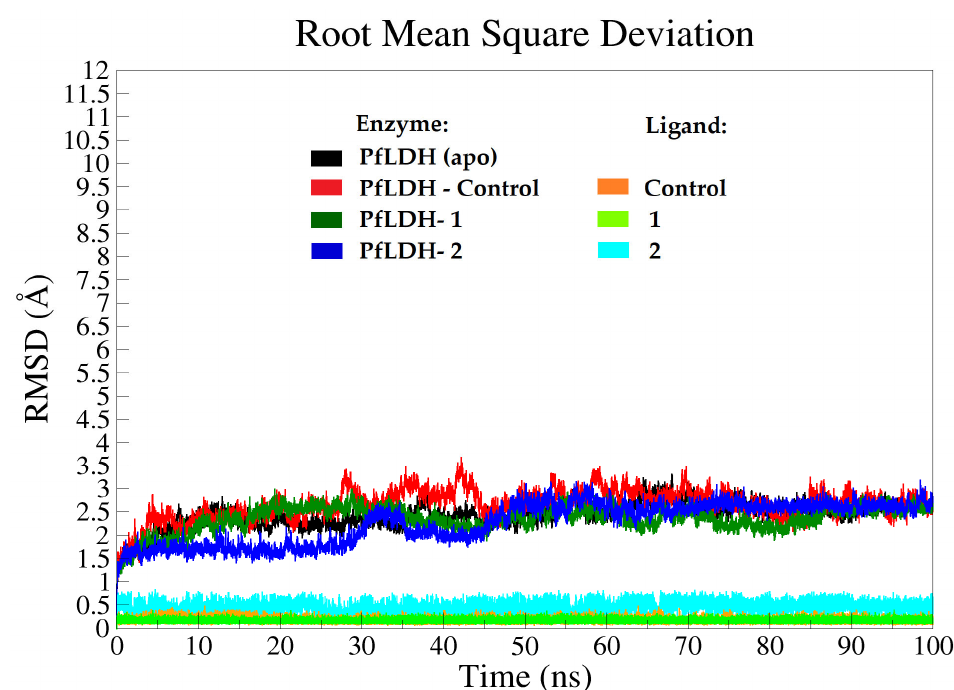
Figure 3. The root mean square deviation (RMSD) plots of the enzyme and ligand backbone atoms for the selected systems. Apo ‐ Pf LDH (black), Pf LDH ‐ control (red and orange), Pf LDH ‐ 1 (Dark green for the selected systems. Apo- Pf LDH (black), Pf LDH-control (red and orange), Pf LDH-1 (Dark green and lime), and Pf LDH ‐ 2 (blue and cyan). and lime), and Pf LDH-2 (blue and